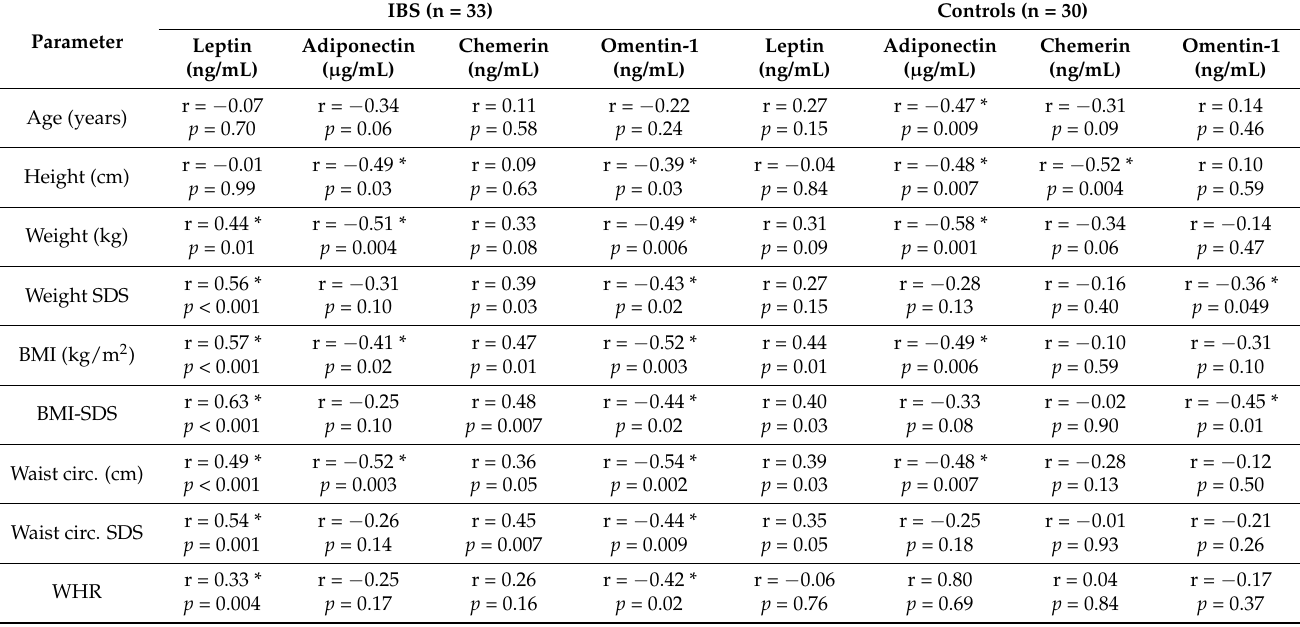
Table 2. Analysis of correlations between examined adipokines and anthropometric